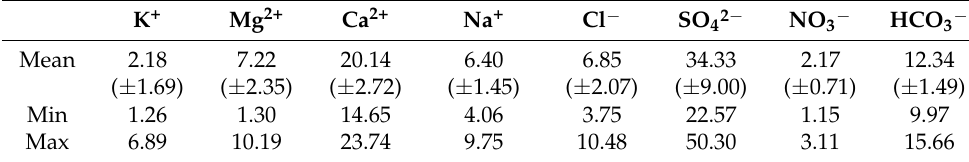
Table 1. Summary of the water chemistry analysis of 45 grab water samples.